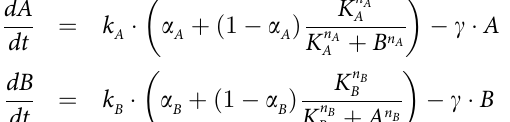
S2 Fig. Genetic potential increases around the bistable region at high nonlinearity for a toggle switch model. Here we consider an alternative model that can produce bistability and then epigenetic switching based on a toggle switch: